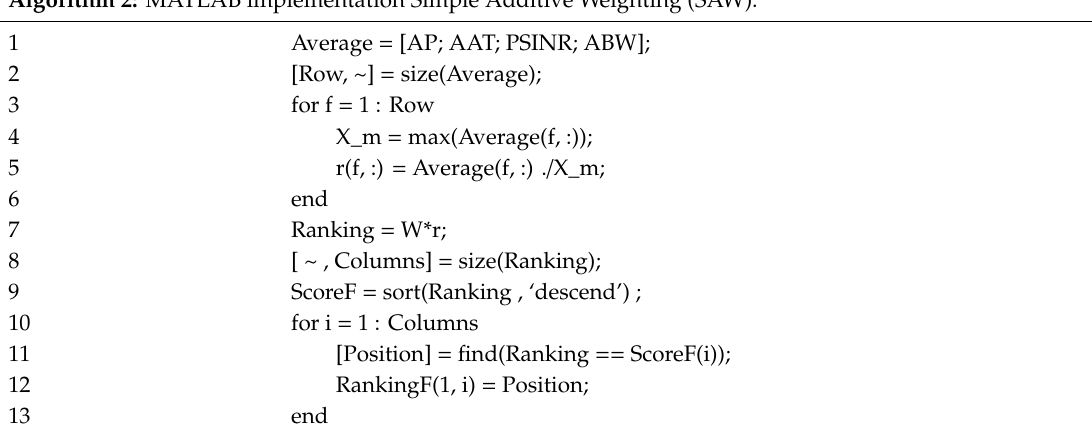
Algorithm 2: MATLAB implementation Simple Additive Weighting